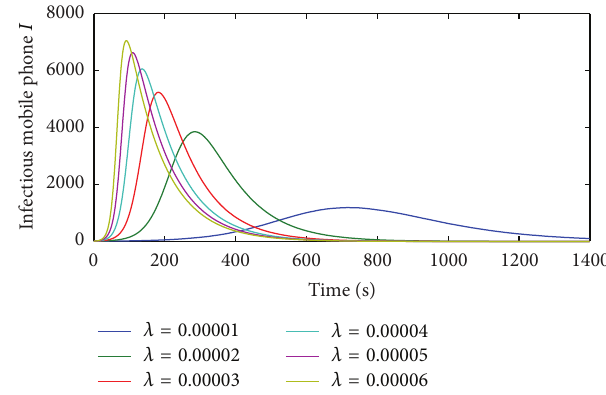
Figure 10: Effect of the contact infection rate 𝜆 in the M-SIR model. All infected mobile phones vanish and the population in the long term is in an immune state. According to Theorem 3, the basic reproduction number 𝑅 1 is about 0.8 < 1 ,